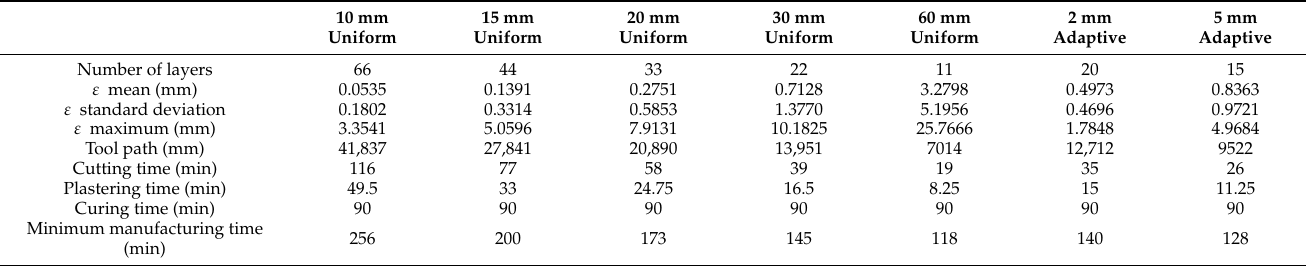
Table 3. The simulation results.